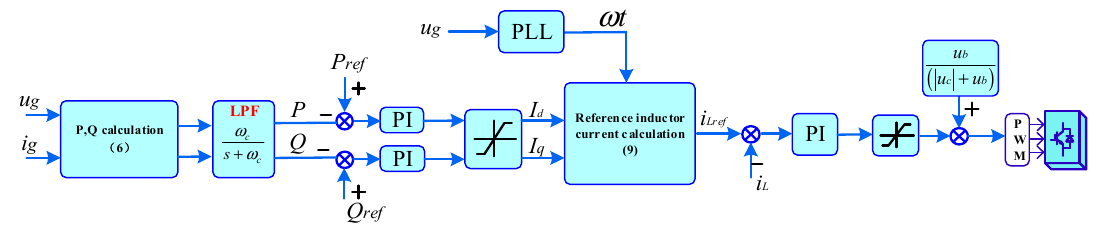
Figure 3. Control block diagram of the presented converter.